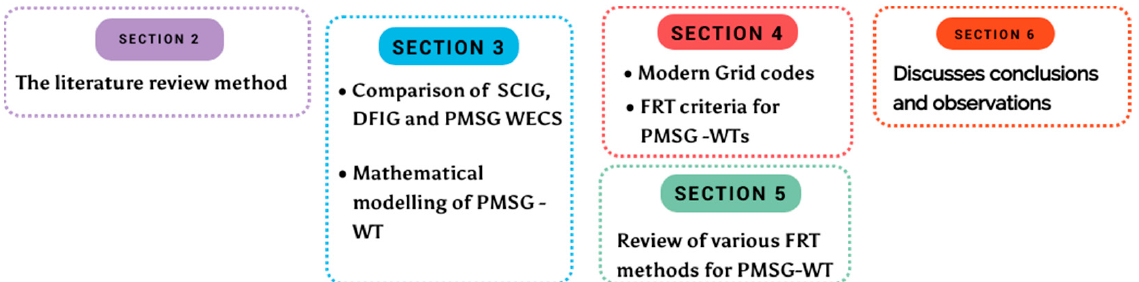
Figure 3. A diagrammatic representation of the article's overall structure.